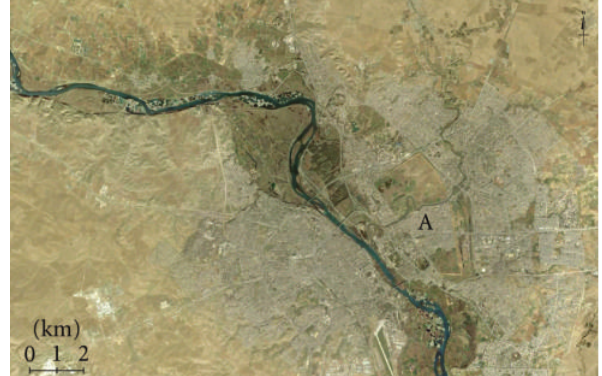
Figure 17: Nineveh (A) and the surrounding territory in a pan- sharpened (bands 3-2-1) QuickBird-2 image of